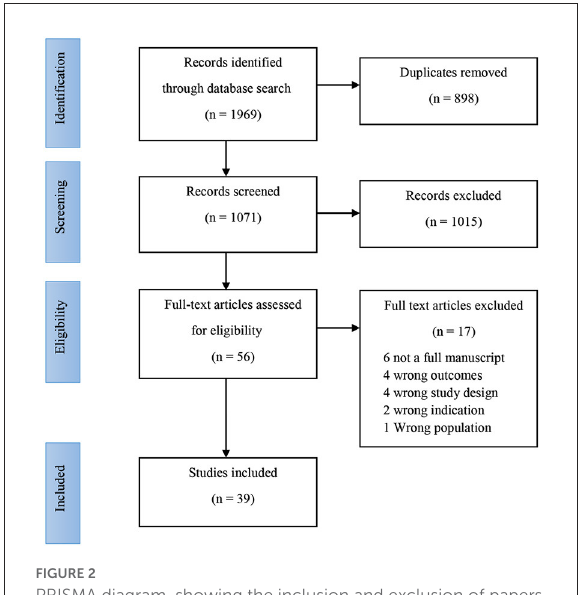
FIGURE2 PRISMA diagram, showing the inclusion and exclusion of papers in the review.